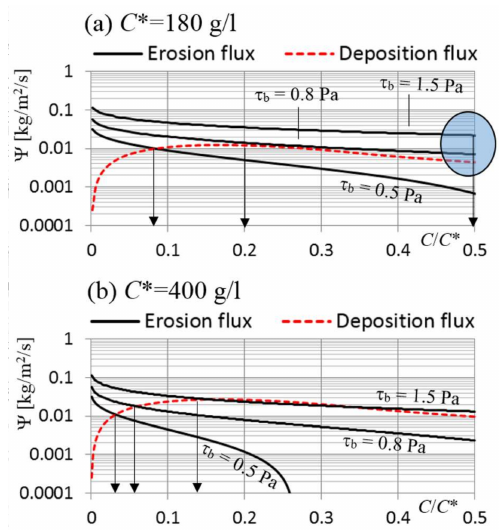
Figure 5. Erosion and deposition fluxes in (25) as a function of bed shear stress, τ b , plotted against C / C * for the parameter settings of the main configuration (see Table 1) and an assumed constant lutocline height of h = 4 cm, for ( a ) C * = 180 g/L and ( b ) C * = 400 g/L. Crossings between curves imply equilibrium states of zero fluxes. Arrows indicate the corresponding values of C / C *. Additional treatment is required in the regime highlighted by the circle in ( a ) to limit concentrations by the gelling concentration at C / C * ≈ 0.5. See text for more details. The equilibrium mud concentrations in ( a ) are 15, 45 and C */2 = 90 g/L; and in ( b ) 13, 24 and 60 g/L. With C * = 180 g/L, the bed shear stress of τ b = 0.5 Pa leads to an equilibrium suspended